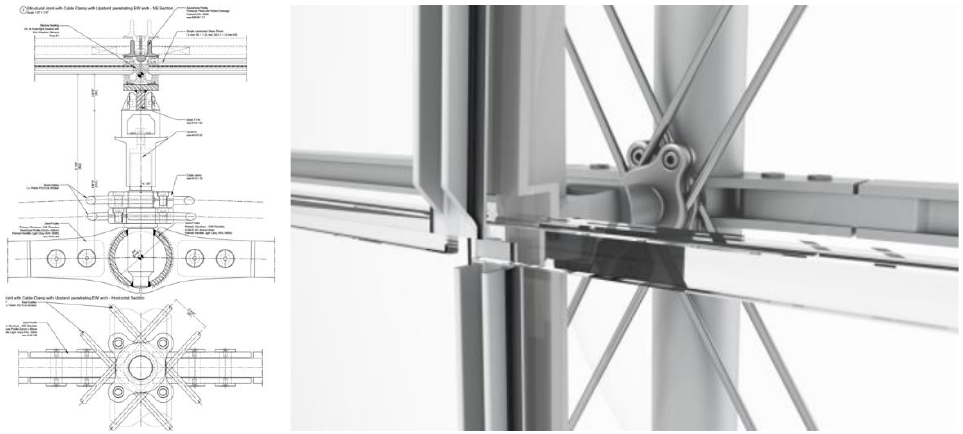
Figs. 14, 15 Typical Glazing detail 2D and 3D (Images: Knippers